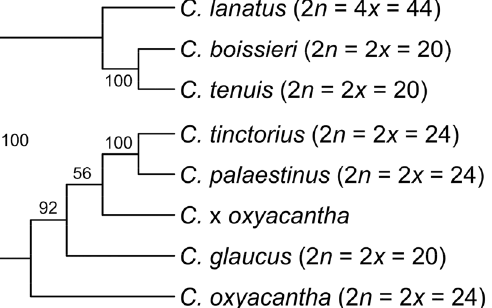
Figure 2. Unrooted SVDquartet species tree using the multi-species coalescent as tree model on the GBS dataset of the Carthamus target species. The individuals also analyzed in Fig. 1 were partitioned according to their species affiliation, with the introgressed C. × oxyacantha individuals treated as a separate category. Ploidy levels and chromosome numbers are listed behind the species names. Numbers along branches indicate bootstrap support values (≥